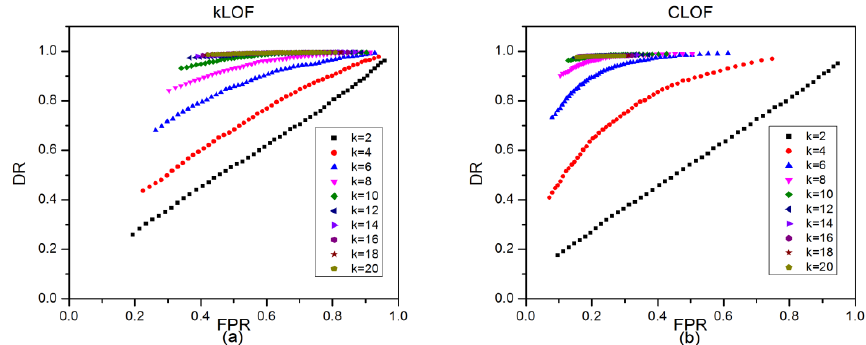
Figure 14. ROC curves of kLOF and CLOF methods on the Shuttle dataset with different k related to t : ( a ) the ROC curves of kLOF method; ( b ) the ROC curves of CLOF method.